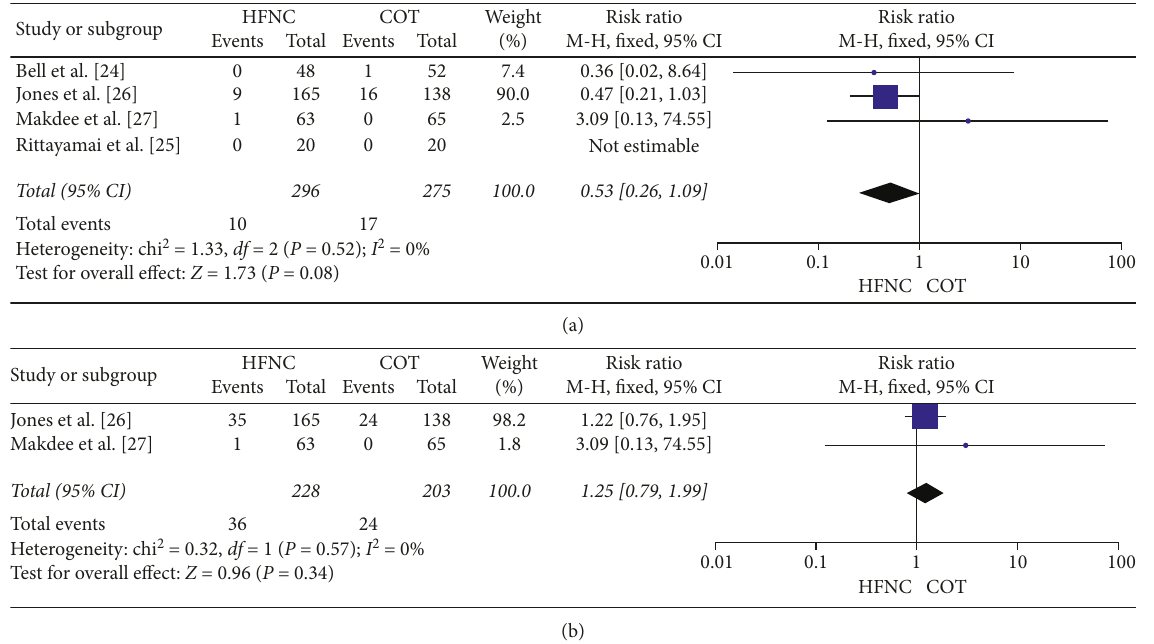
Figure 3: Intubation rate and mortality rate. (a) Intubation rate: HFNC group versus COT group. (b) Mortality rate: HFNC group versus COT